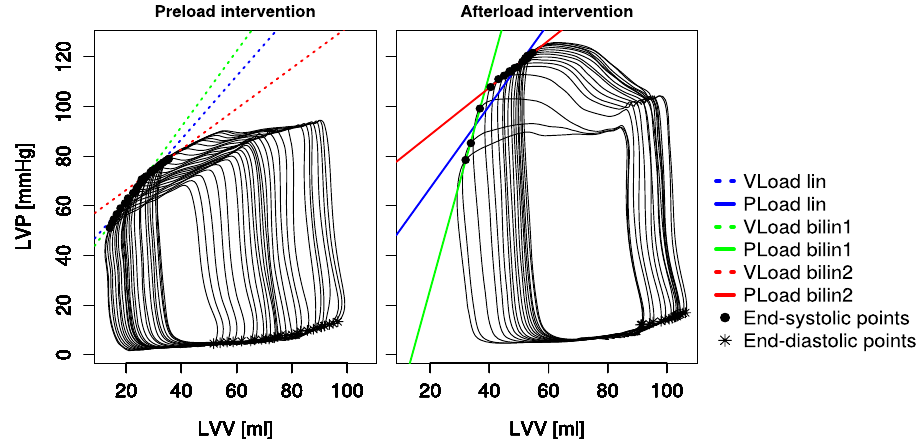
Figure 3. Examples of a pre- and afterload intervention. In both cases, a linear ESPVR (lin) and a bilinear ESPVR consisting of two linear regressions (bilin1 and bilin2) are shown. The end-systolic and end-diastolic points are shown as black dots and stars, respectively. ( LVV left ventricular volume, LVP left ventricular